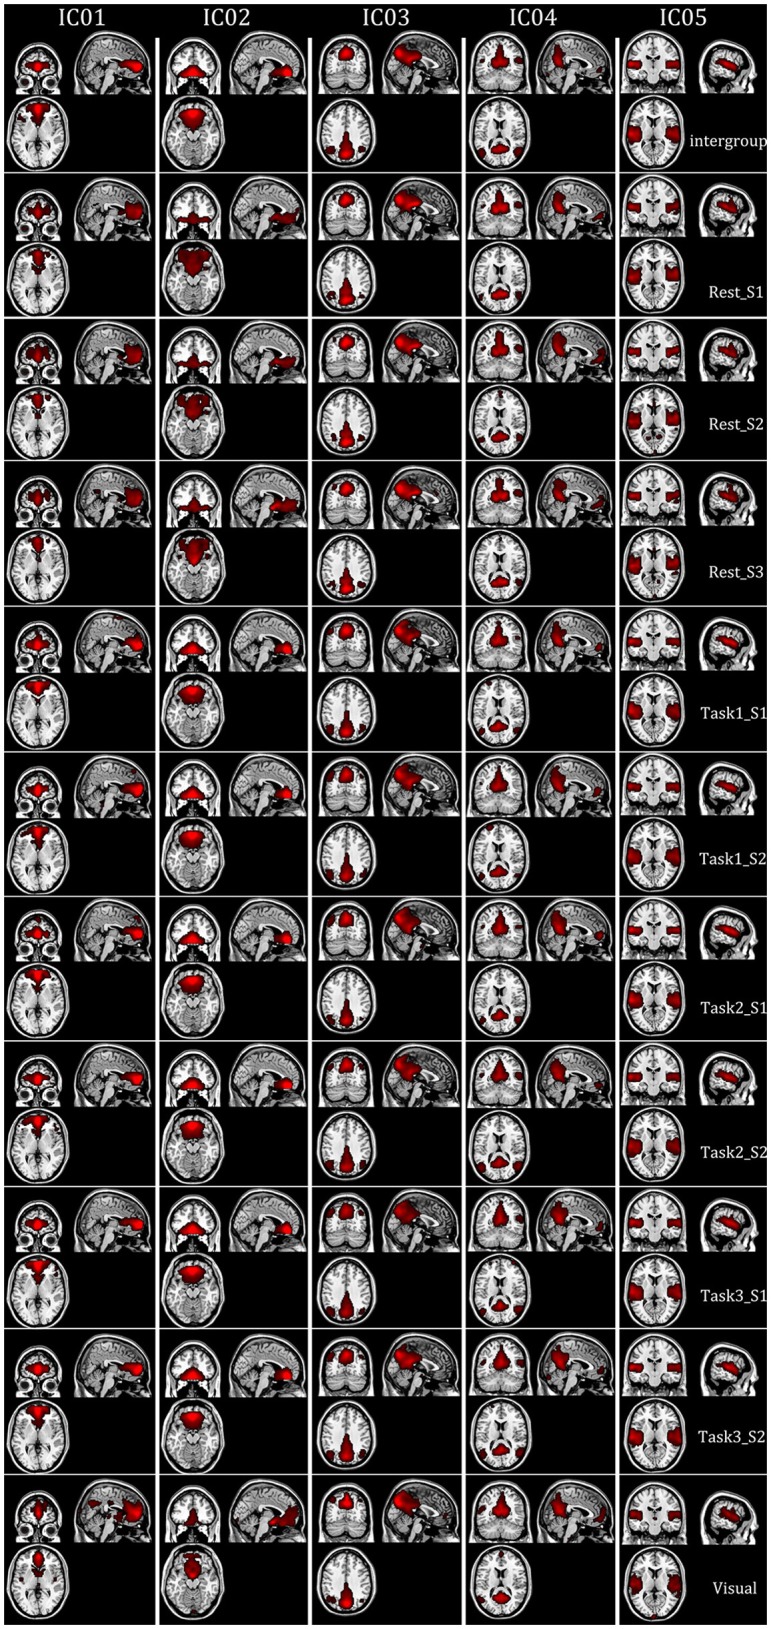
The spatial map distribution of first five BFNs at the intergroup and intragroup-specific levels in Experiment 3: each column depicted a BFN at the intergroup and intragroup-specific levels; Rest_S i denoted the ith session of test-retest resting-state datasets; Task i_S j denoted the jth session of Task i from the test-retest task-related datasets; Visual denoted the visual task dataset.